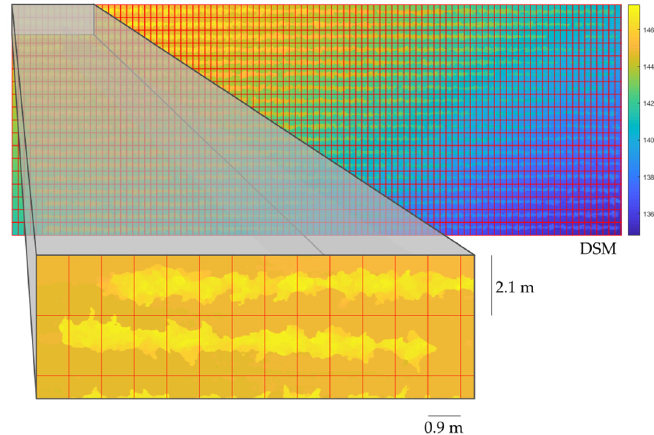
Figure 3. The Digital Surface Model (DSM) raster (colored with a pseudo-colors palette to emphasize the altitude of each pixel above sea level) employed during the MATLAB processing and divided into 0.90 m × 2.10 m blocks (as shown in the enlarged upper left portion of the ortho-image). Canopy and terrain pixels are represented with different colors in each block.